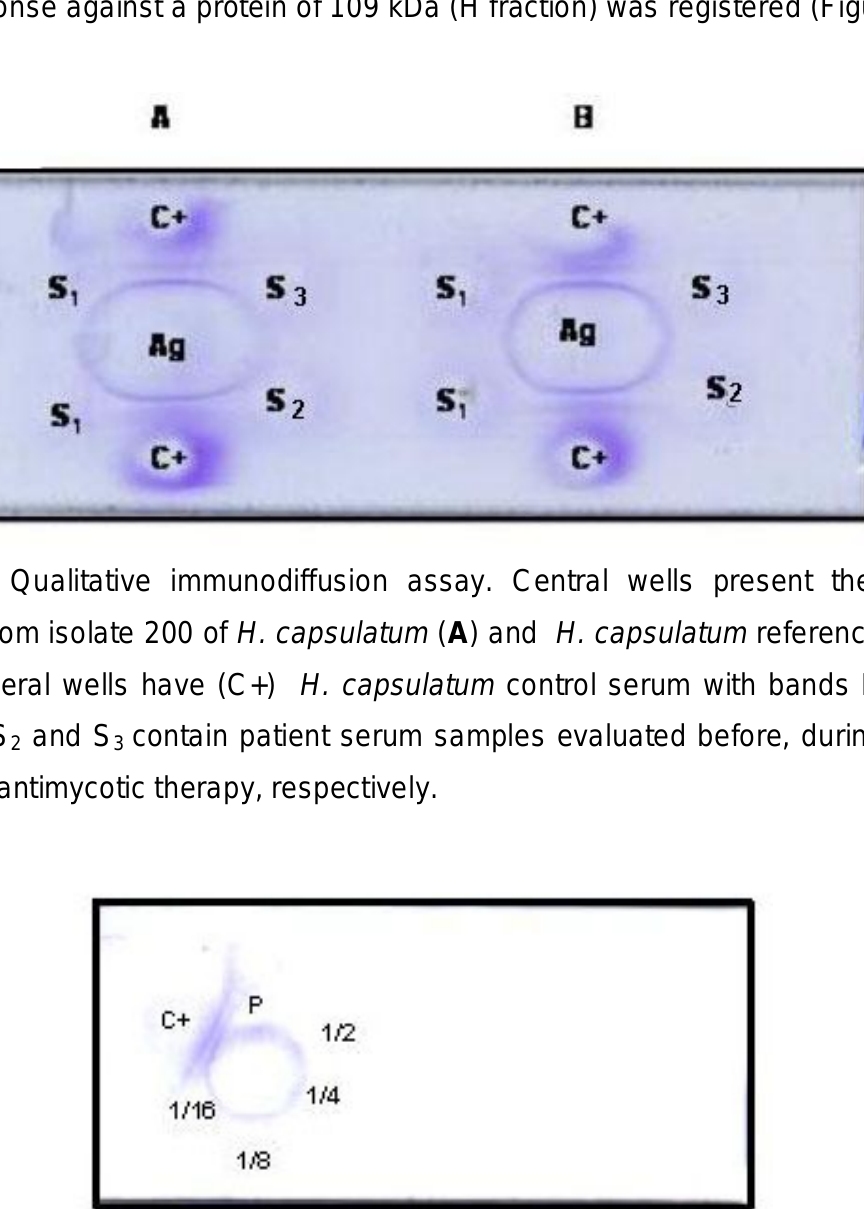
Figure 2. Semiquantitative immunodiffusion assay. The circulating anti- H. capsulatum antibody titer observed was